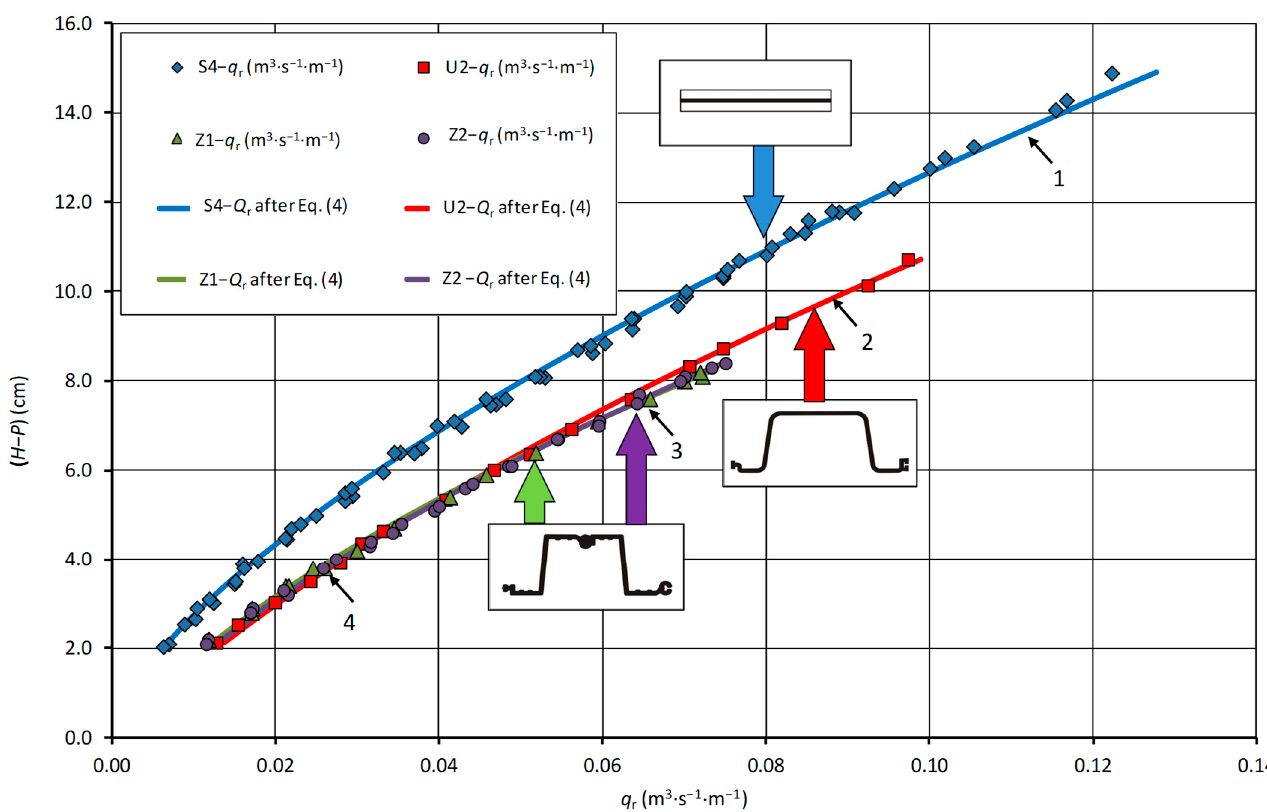
Figure 9. Unit flow rates of the tested regulator variants: 1—variant S4; 2—variant U2; 3—variant Z1; 4—variant Z2.